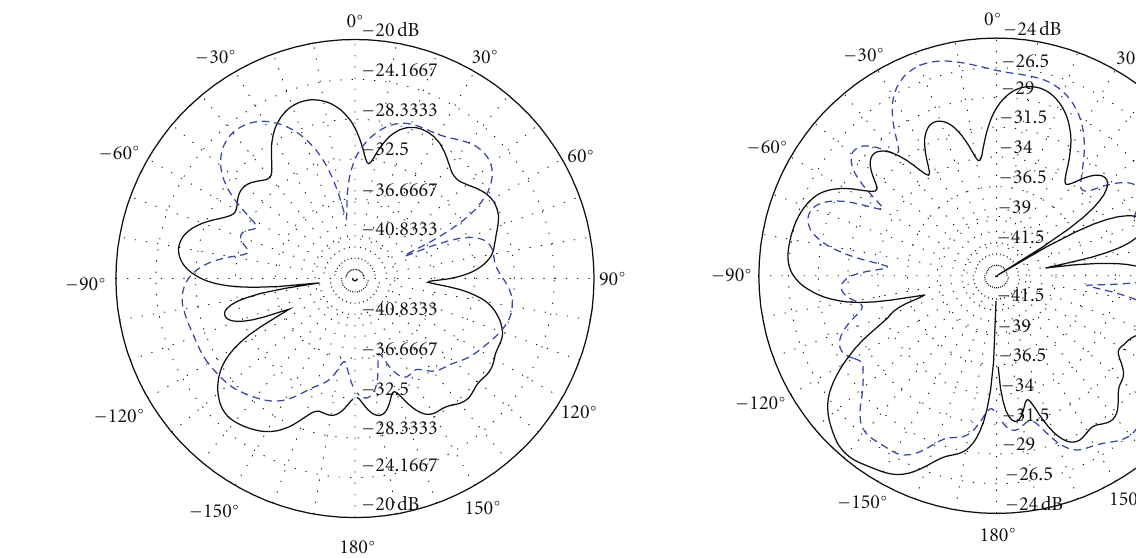
Figure 7: Measured radiation pattern at 2.4GHz on XZ plane (blue) and YZ plane (black).